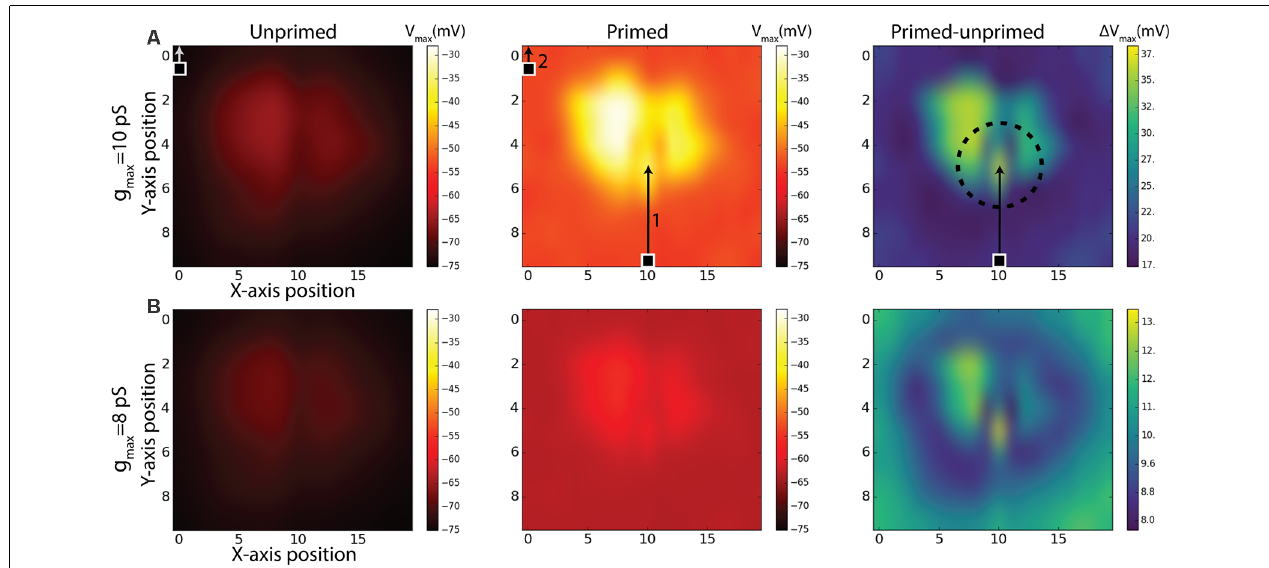
FIGURE 6 | Simulations of Unprimed, Primed stimulus and the difference between the two (Primed-Unprimed). The response fields are mapped to correspond to a view from the anterior side of the brain ( Figure 1A ). The rows (A,B) indicate the same experiment for different NMDA synaptic strengths ( g max ). The 100 ms measurement period is indicated with a target square (probe) and arrow. In the first column (Unprimed) the probe position was varied systematically for each axis (10 × 20) position. The probe traveled for 100 ms corresponding to 10% of the entire vertical path. In the middle column (Primed) a primer (indicated by 1) preceded the probe (indicated by 2). Responses correspond to the maximum membrane potential in the non-spiking version of the model using the BSTMD1 morphology. The dashed circle in the right column (Primed-Unprimed) on row (A) indicates the area which could be expected to have higher activity (facilitation) due to the recent disappearance of the primer. This expectation can be expected for row (B) as